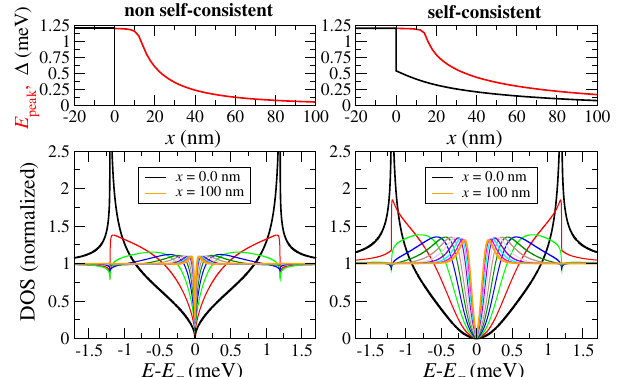
FIG. 13. The lower panels show the computed normalized density of states as a function of energy (measured with respect to the Fermi energy, E ). The parameters of the model are those of F Fig. 12, and the different curves correspond to different positions along the monolayer, x . The curves were computed in steps of 10 nm, ranging from x ¼ 0 (monolayer side of the island edge) to x ¼ 100 nm. The lower left panel corresponds to a calculation where the order parameter in the monolayer is assumed to be zero everywhere, while the lower right panel corresponds to the case in which the order parameter was calculated in a self-consistent manner. The upper panels show the corresponding order-param- eter profiles (black lines) and the spatial evolution of the coherent peaks (red lines).